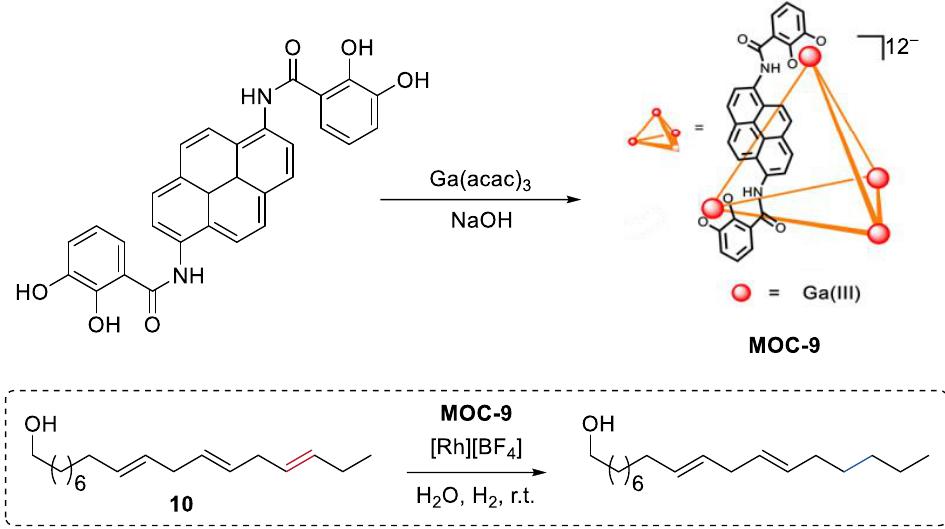
Figure 8. Selective hydrogenation of polyenol catalyzed by rhodium complex encapsulated within MOC-9 [63]. Reaction additions: 10 (0.05 mmol), MOC-9 (10 mol%), [Rh][BF 4 ] (10 mol%), H 2 O (1.0 mL), H 2 , r.t. Reprinted/adapted with permission from Ref. [63]. Copyright 2019 American Chemical Society.